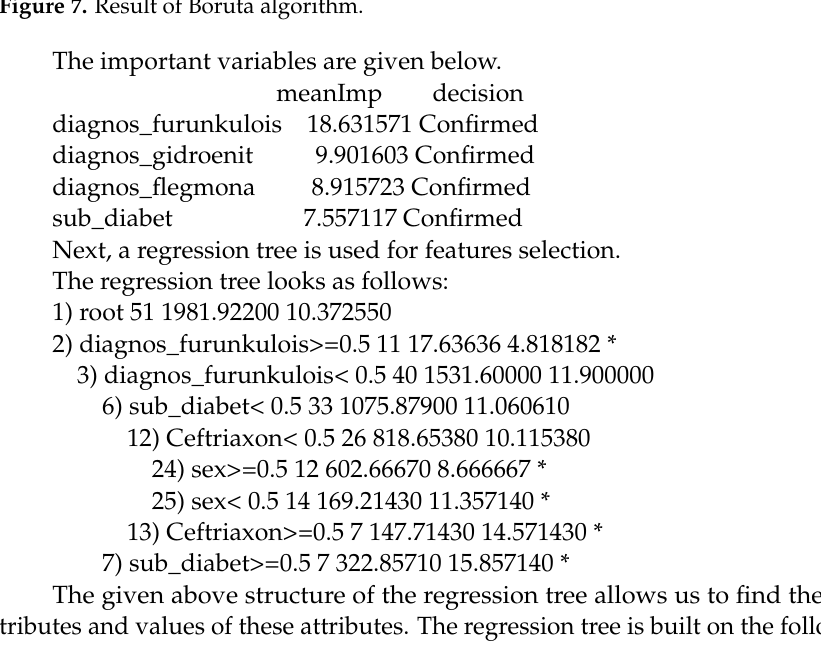
Figure 7. Result of Boruta